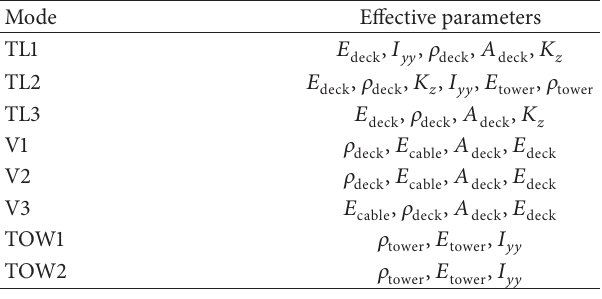
Table 6: Effective parameters on the first mode responses of the bridge.